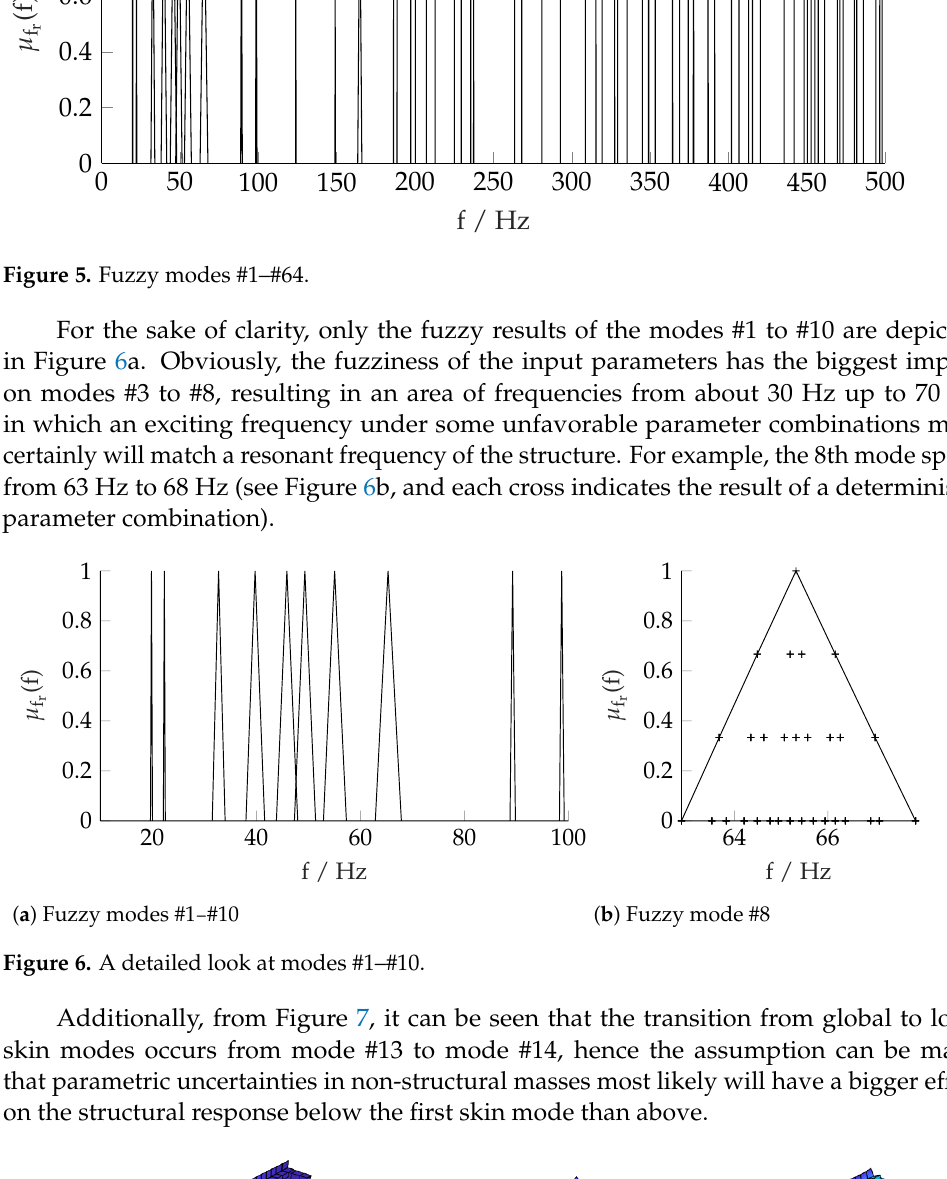
Figure 4. Uncertain parameters